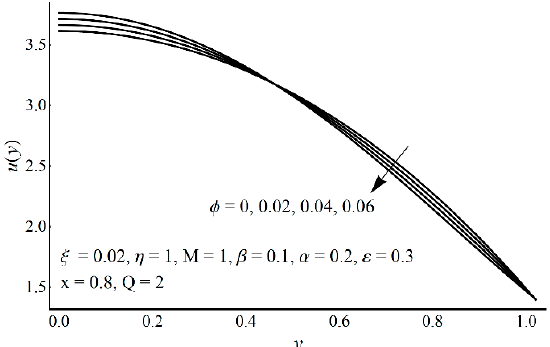
Figure 4. Axial velocity for various values of cilia length parameter ε .